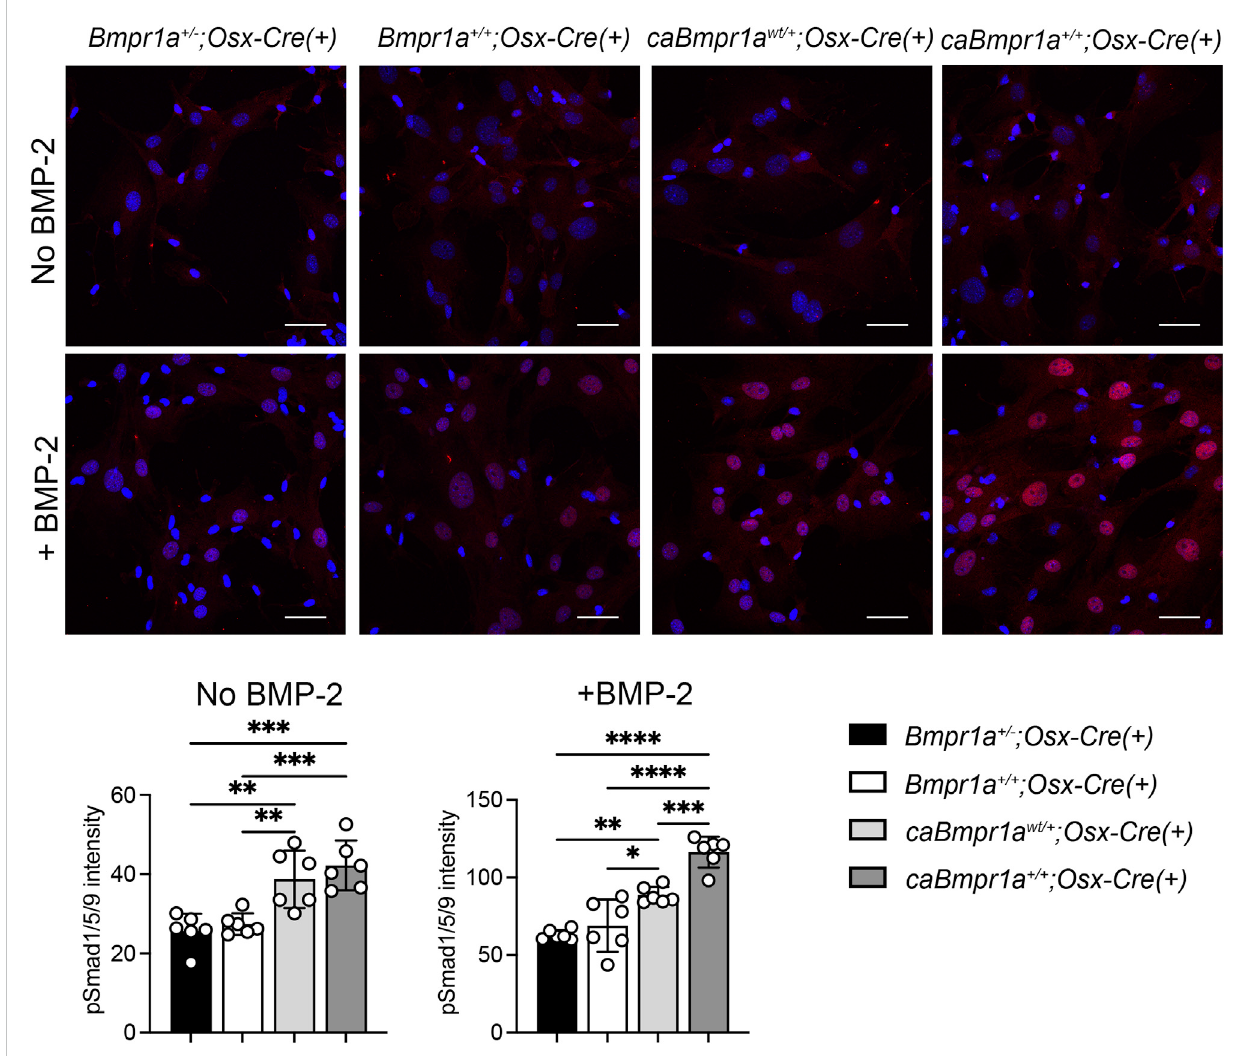
FIGURE 6 Immuno fl uorescence detection of phosphorylated form of Smad1/5/9 in bone marrow stromal cells (BMSCs) from the mouse tibia. BMSCs were incubated with/without 100 ng/mL ofrhBMP-2 for 30 min.Intensity ofpSmad1/5/9(red) inthe nucleus was measured (n = 6 male for each group).